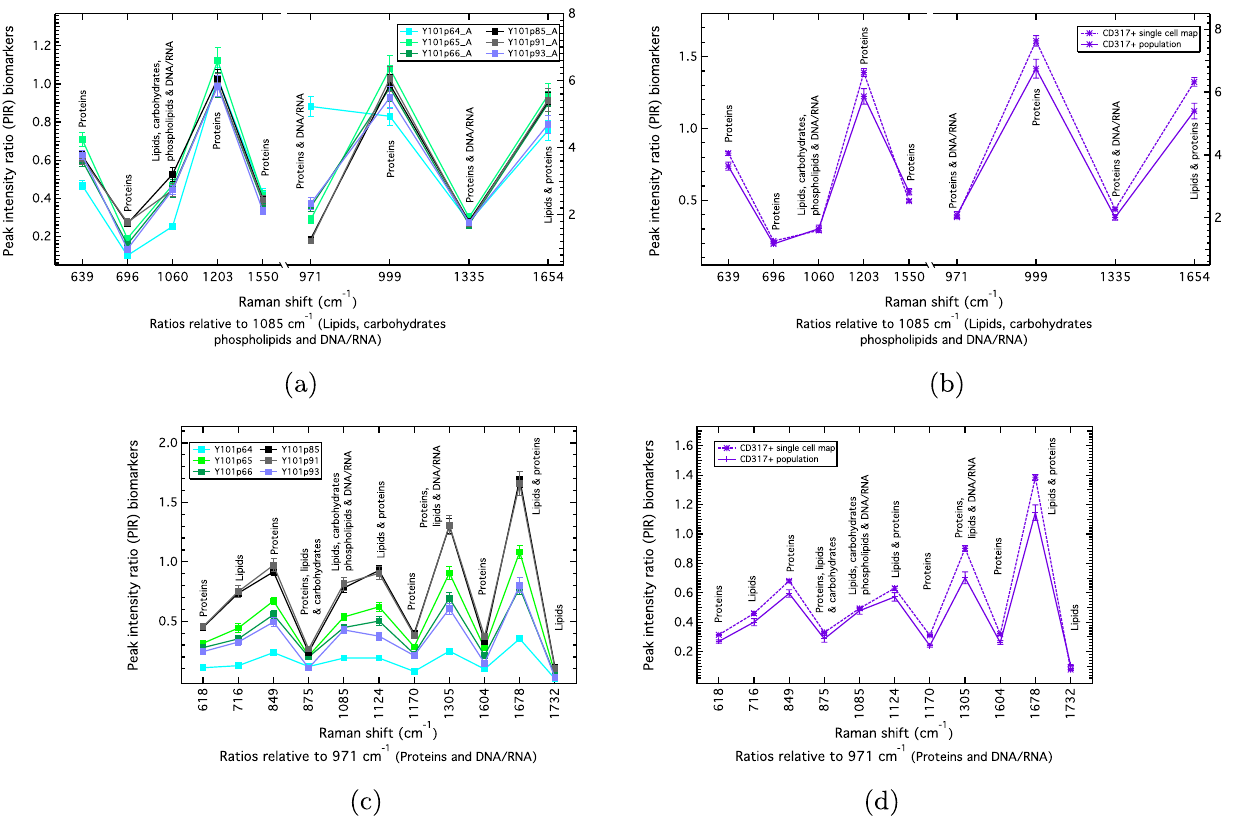
− 1 − 1 and 971 cm PIR panels between experimental replicates